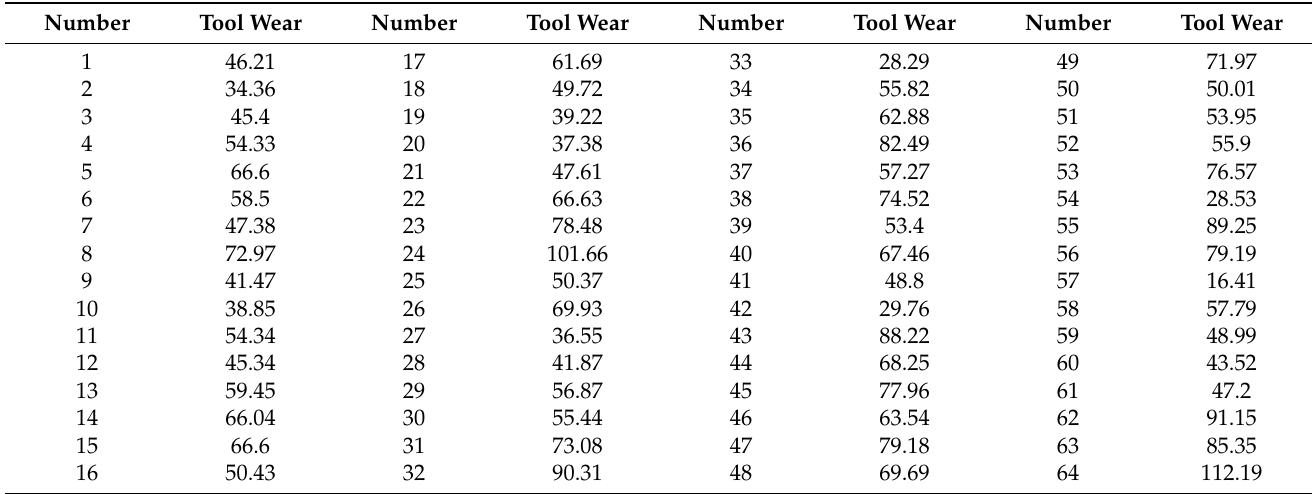
Table 3. Experimental results of tool wear ( µ